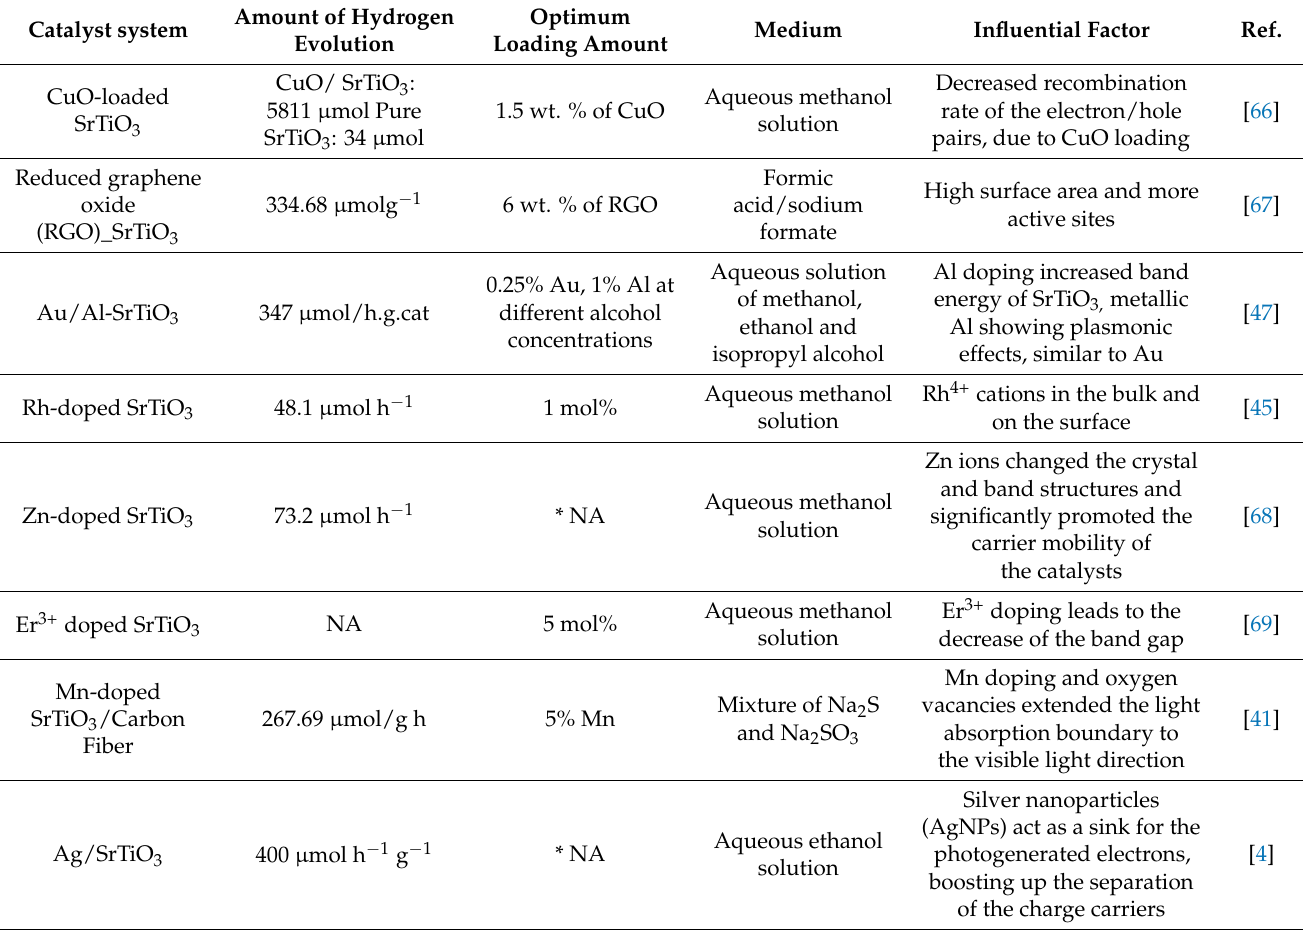
Table 3. Doped SrTiO 3 for the photocatalytic generation of